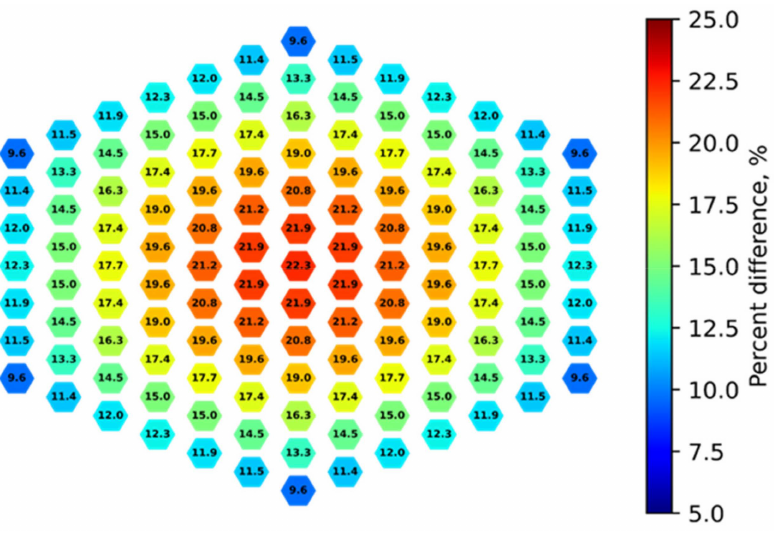
Figure 11. Mid-plane ( z = 60 cm) flow area percent difference. The outlet bulk coolant temperature distributions with and without T/M feedback are detailed in Figure 12.